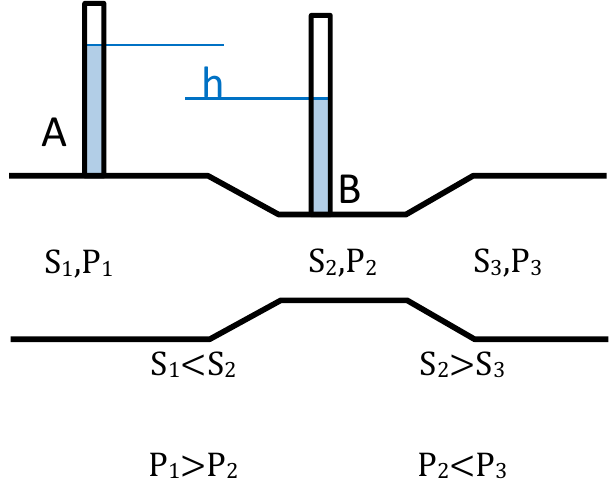
Figure 3. Representation of the Venturi e ff ect. S: speed; P :